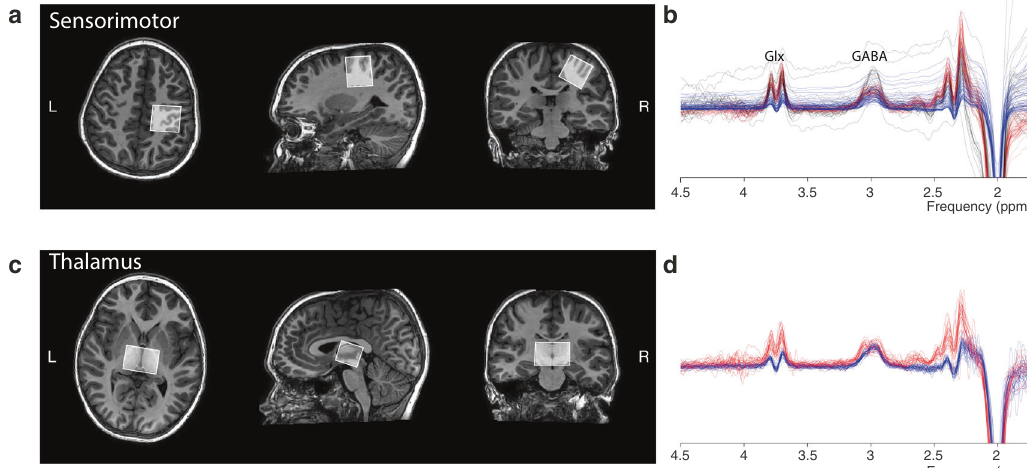
Fig. 1 Voxel placement and example spectra. a Depiction of voxel placement for the left primary sensorimotor cortex (SM1) in a randomly selected participant. b Spectra from all the participants, color coded by the acquisition phase from which they were collected (black = phase 1, blue = phase 2, and red = phase 3 – see Supplementary Methods). c Voxel placement for the thalamus (Thal) in a randomly selected participant. d Spectra from all participants, color coded by acquisition phase. Note: no phase 1 data were acquired in the Thal.